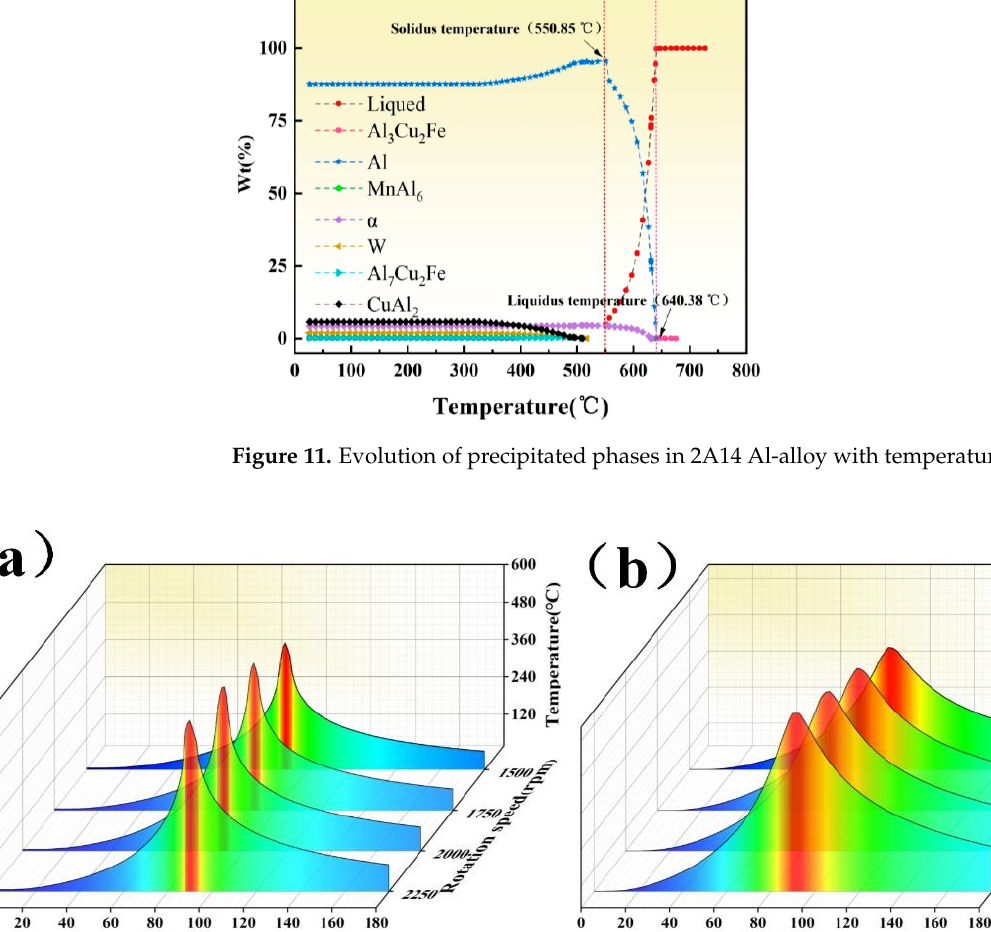
Figure 12. Temperature variation in various regions of welded T-joints at different rotation speeds: ( a ) WNZ, ( b ) TMAZ.